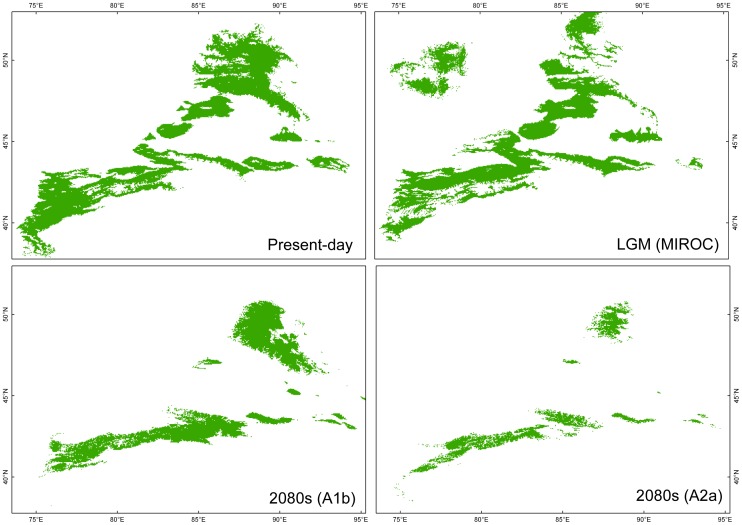
Modelling distribution of Clematis sibirica.Maps depicting potential distribution of Clematis sibirica in arid Eastern Central Asia during present-day and at LGM based on the MIROC model, and future (2080’s) based on the A1b and A2a scenarios.